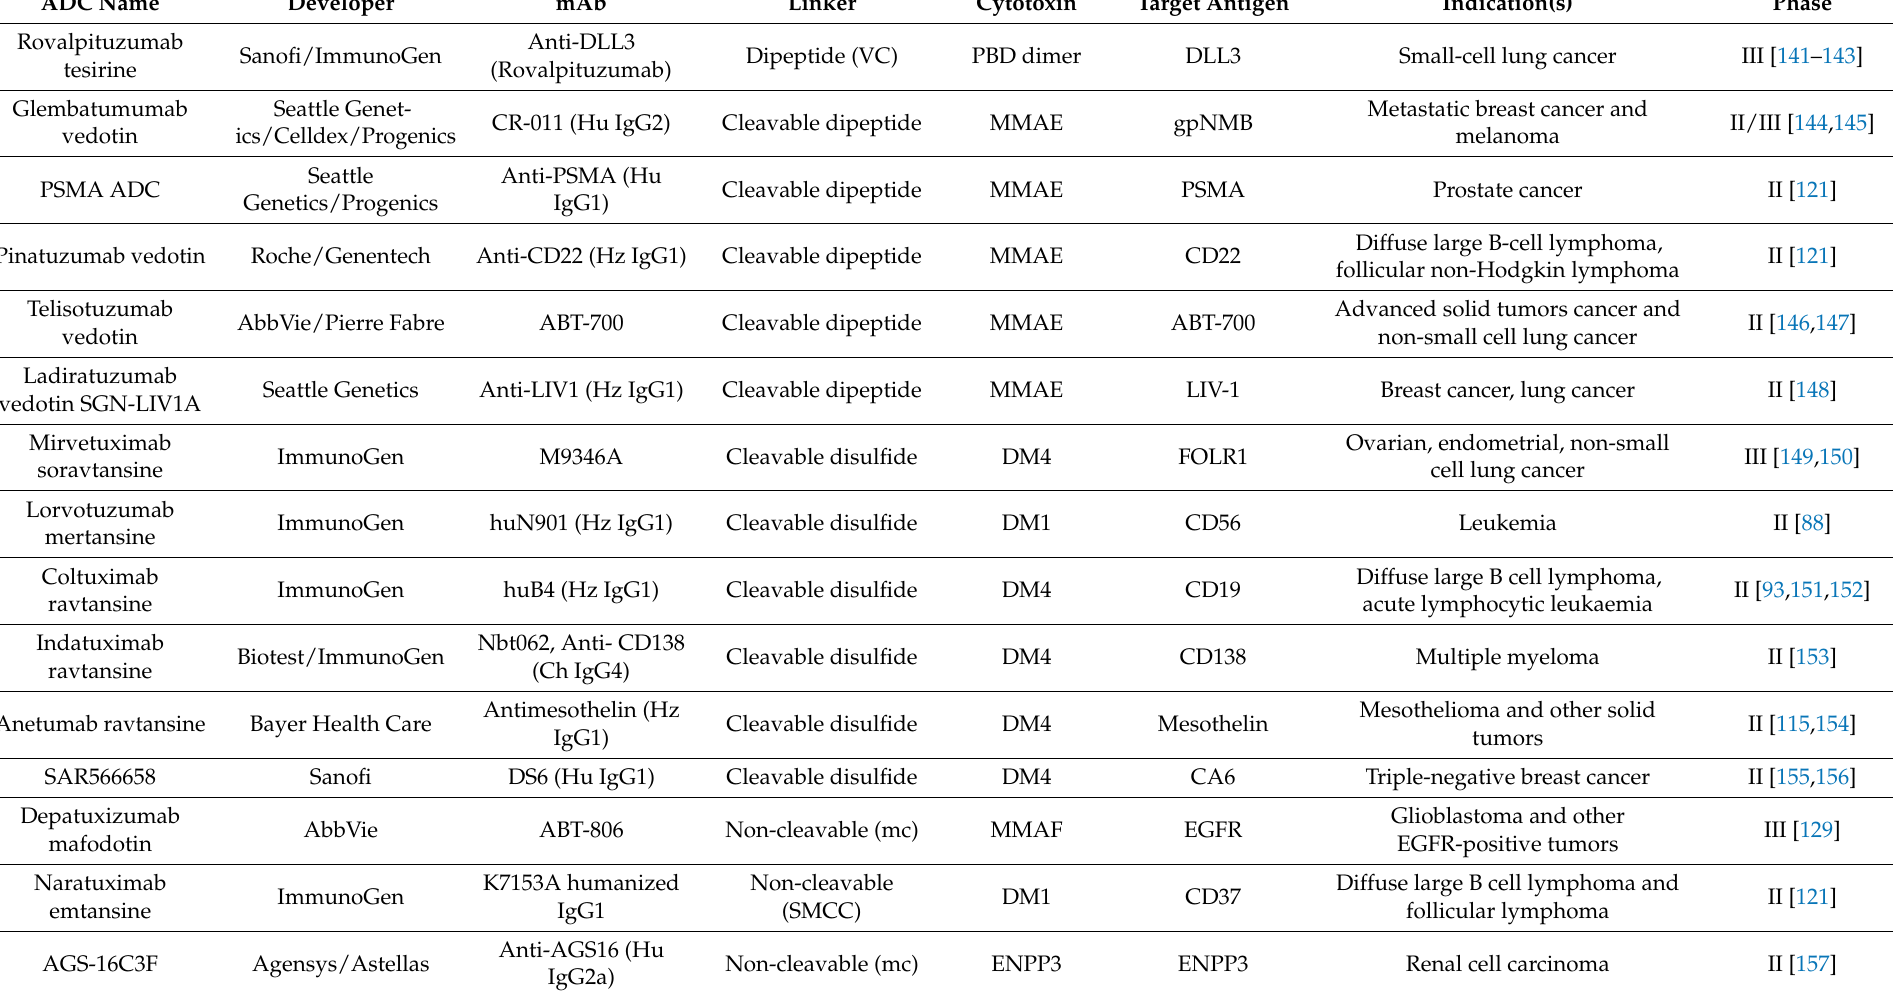
Table 3. Selected ADCs currently in clinical